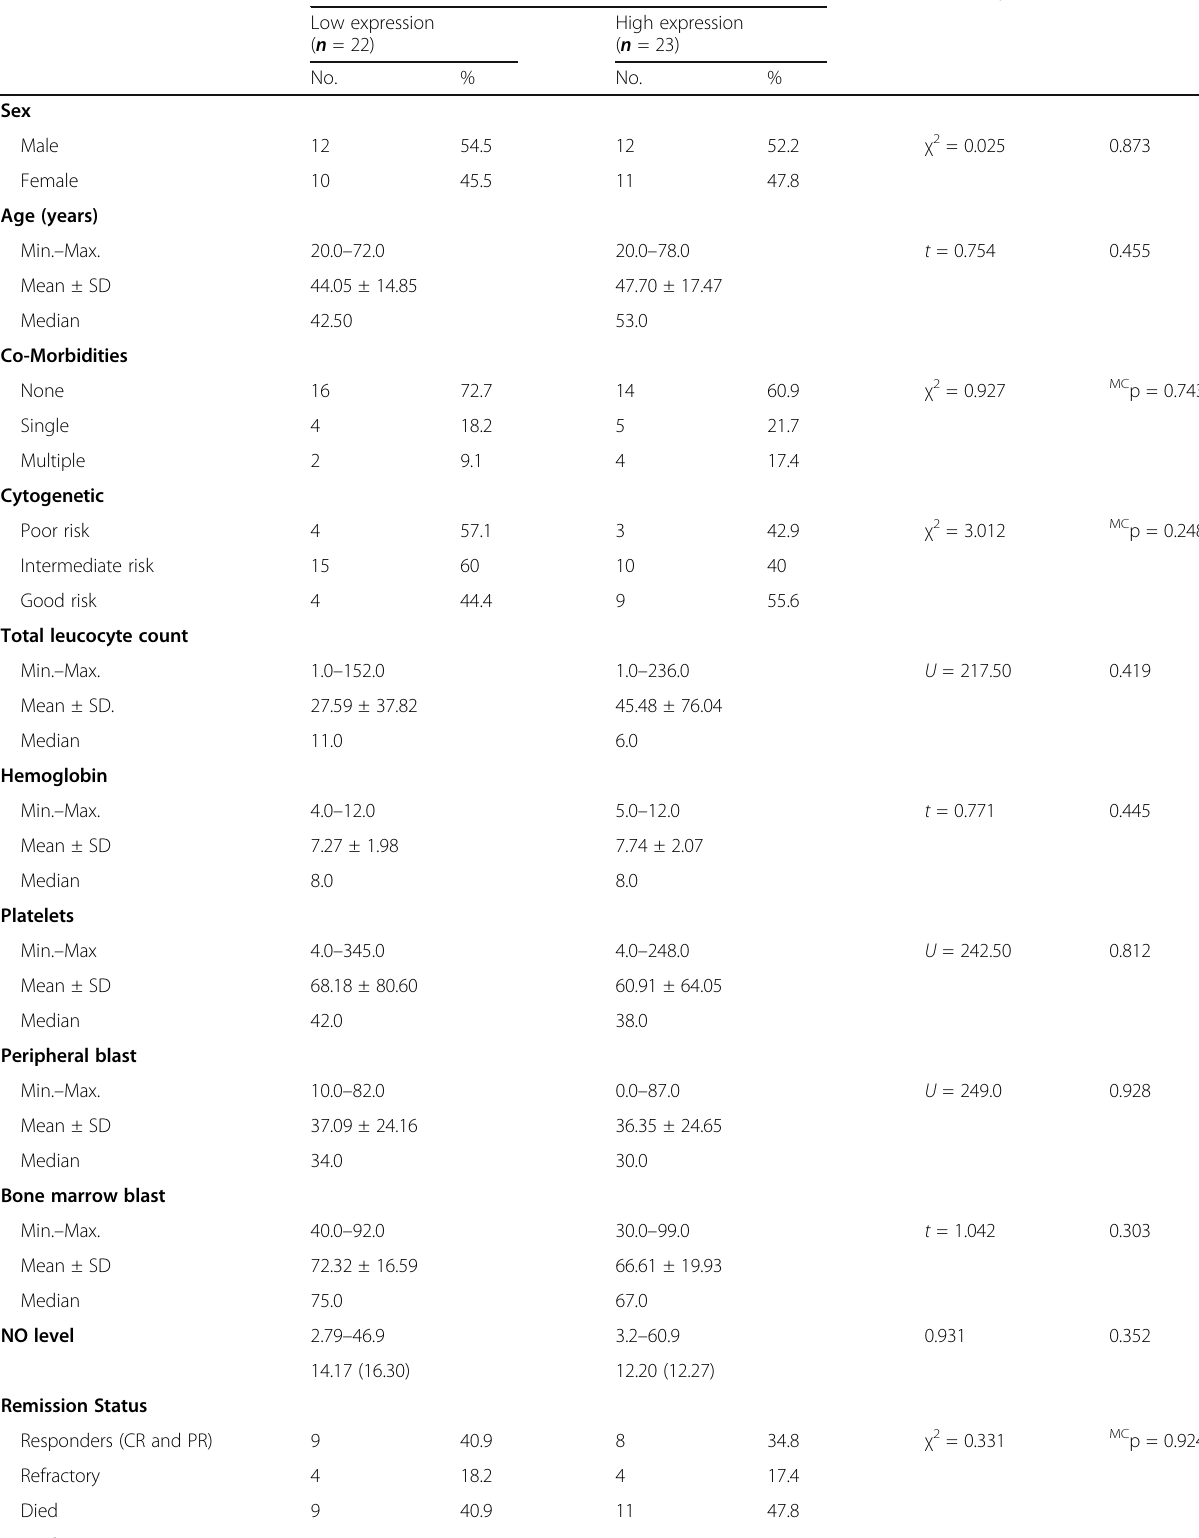
Table 4 Comparison between low and high DNMT3a gene expressors with respect to their demographics as well as clinical data Level of expression Test of sig.